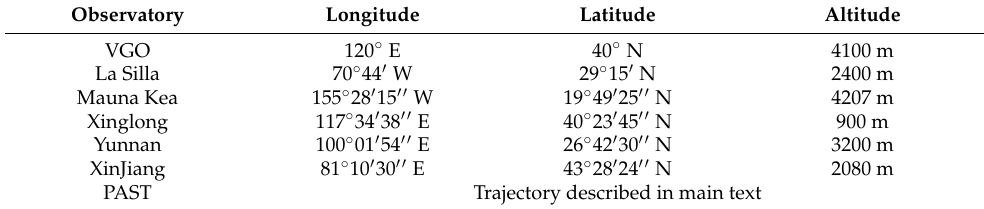
Table 5. Locations of